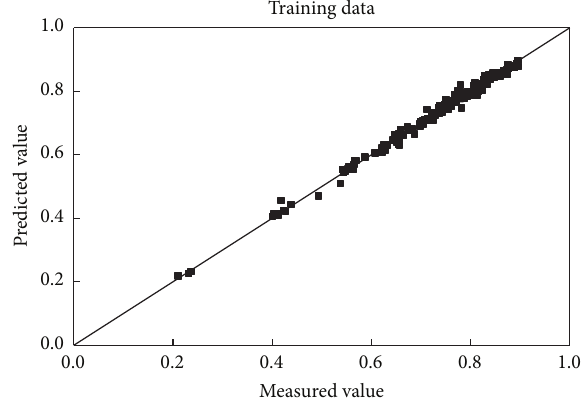
Figure 4: Comparison of the predicted and measured wall factors of cylinders for the training data.